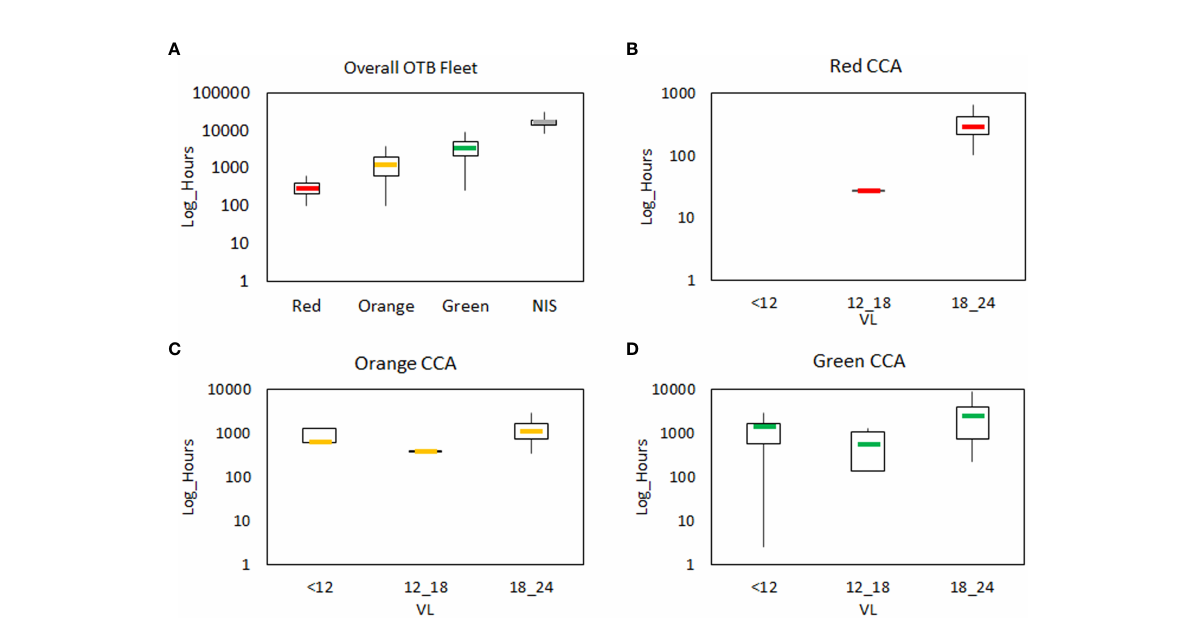
FIGURE 6 The total yearly fi shing effort (hours in Log scale) of the OTB fl eet estimated by SMART model. In (A) the hourly effort is reported for the overall OTB fl eet in the CCAs and Northern Ionian Sea. The hourly effort by LOA segments is reported in (B) for the Red CCA, in (C) for the Orange CCA and in (D) for the Green CCA. LOA segments are split into vessels lower than 12 m (<12), vessels between 12-18 m (12_18) and those between 18-24 m (18_24). Boxplots report the median (midline), quartiles (box limits); minimum and maximum values (whiskers out of